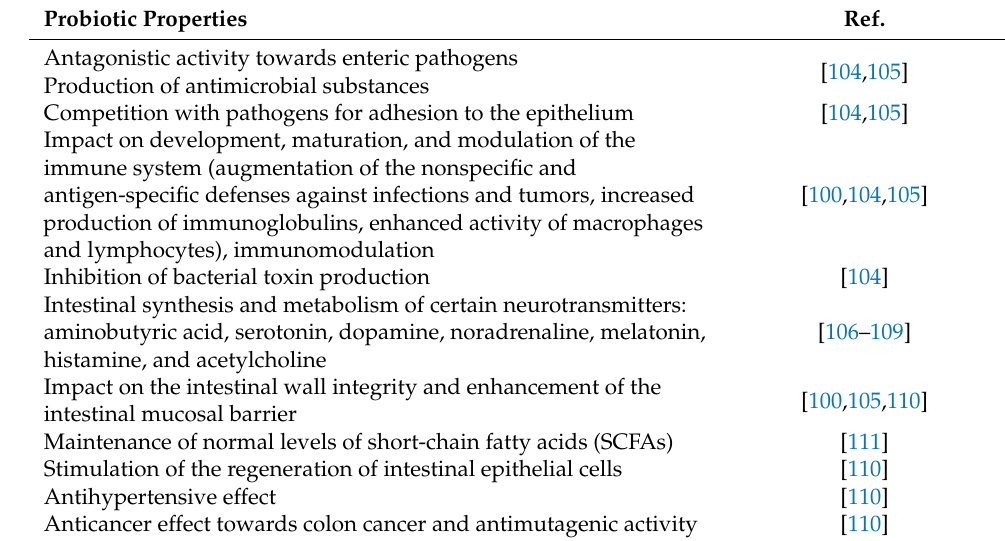
Table 2. Probiotic properties that are beneficial to health. Probiotic